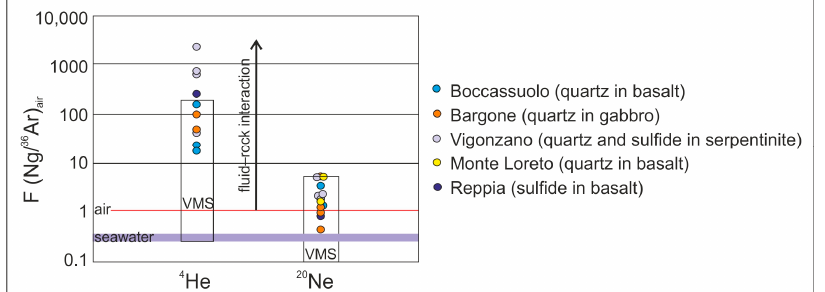
Figure 6. Noble gas isotopic composition of quartz and sulfide-hosted fluid inclusions show evidence of a fluid–rock interaction. This support the establishment of a large fluid circulation system in the crust (typical VMS fields by [44] are shown for reference).